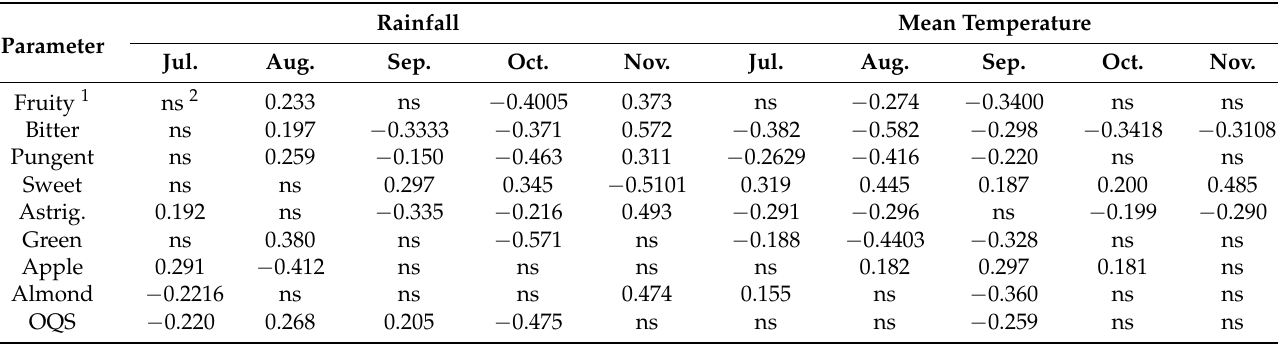
Table 6. Correlation factors of virgin olive oil sensory attributes and microclimate parameters (rainfall and mean temperature; Figure 1) in the period of olives’ intensive growth and ripening. Parameter